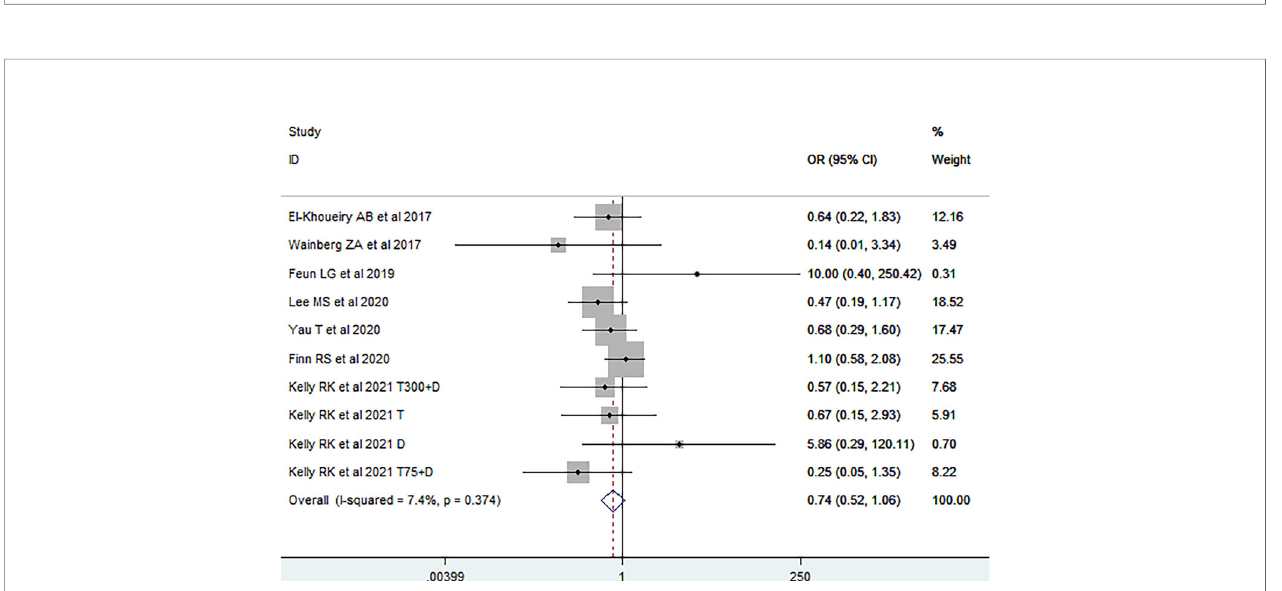
FIGURE 3 | Forest plot of response rate in virally infected HCC strati fi ed by etiology.